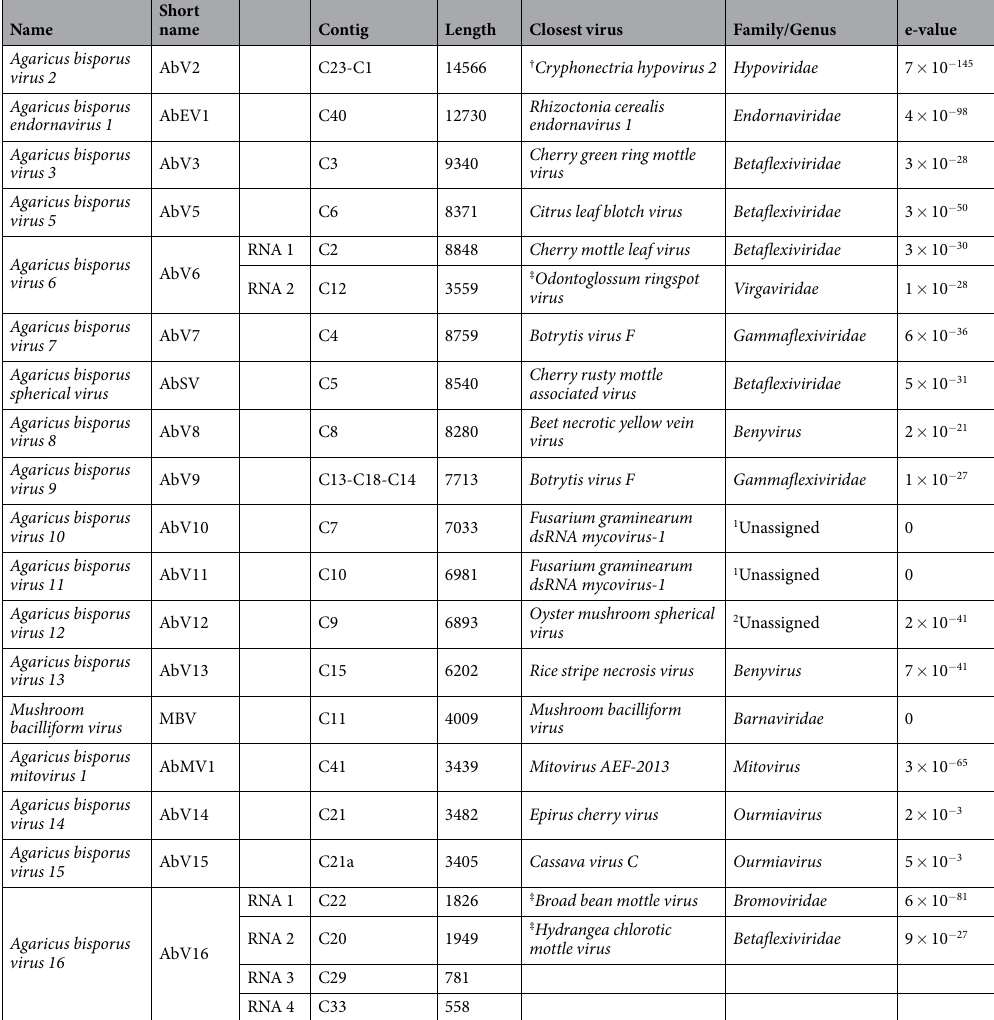
Table 1. Viral RNAs sequenced from samples of A . bisporus fruitbodies and their length and homology to known viruses. The Name column corresponds to the proposed or given name for the discovered viruses. The Short Name column corresponds to a shortened version of the full name. The Contig column corresponds to contiguous RNA sequences assembled from the Illumina reads for each virus. The Length column is in RNA bases and corresponds to the total length of the virus. The Closest Virus column corresponds to the highest scoring homology (lowest e-value) to the given virus as identified with BLASTX. The e-value column indicates the likelihood of the BLASTX alignment occurring due to random chance. The Family/Genus column corresponds to the homologous viruses’ assigned taxonomic group. 1 Proposed new members of the Hypoviridae family. 2 Proposed new member of the Tymovirales order. † The closest match was to a partial sequence